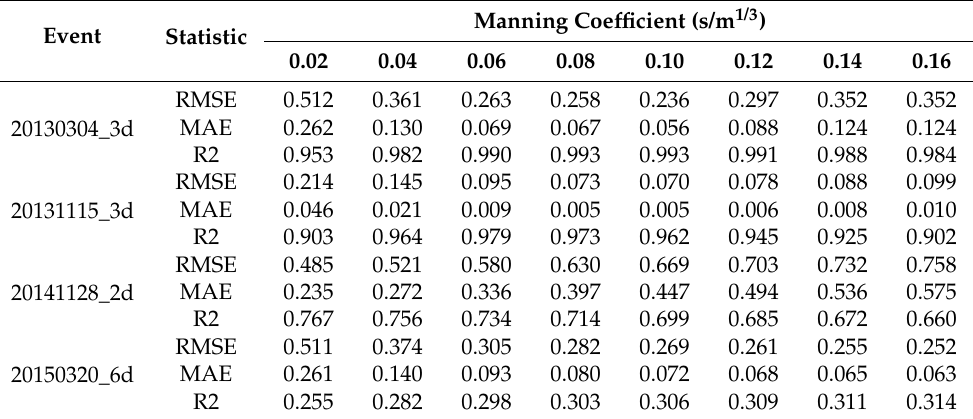
Table 5. Coefficient of determination (R2), mean absolute error (MAE), and root mean square error (RMSE) for each Manning roughness coefficient ( n ) evaluated. Event Statistic